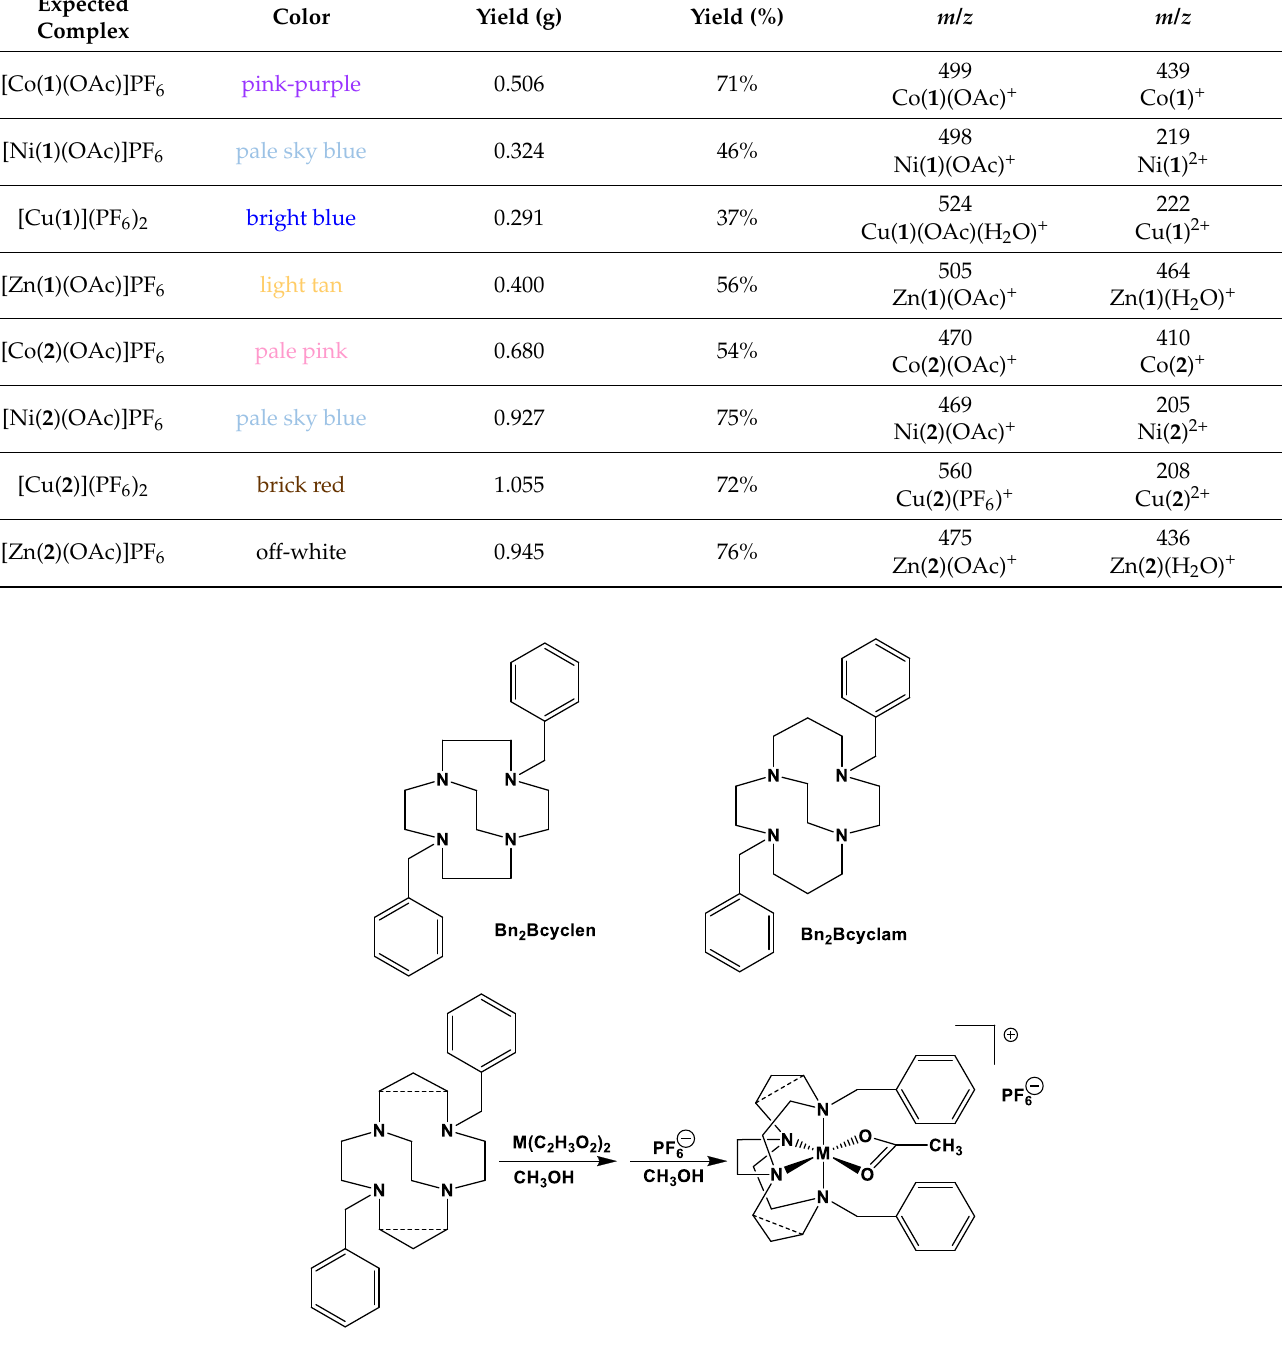
Figure 3. Cross-bridged ligands and complexes for comparison [28].